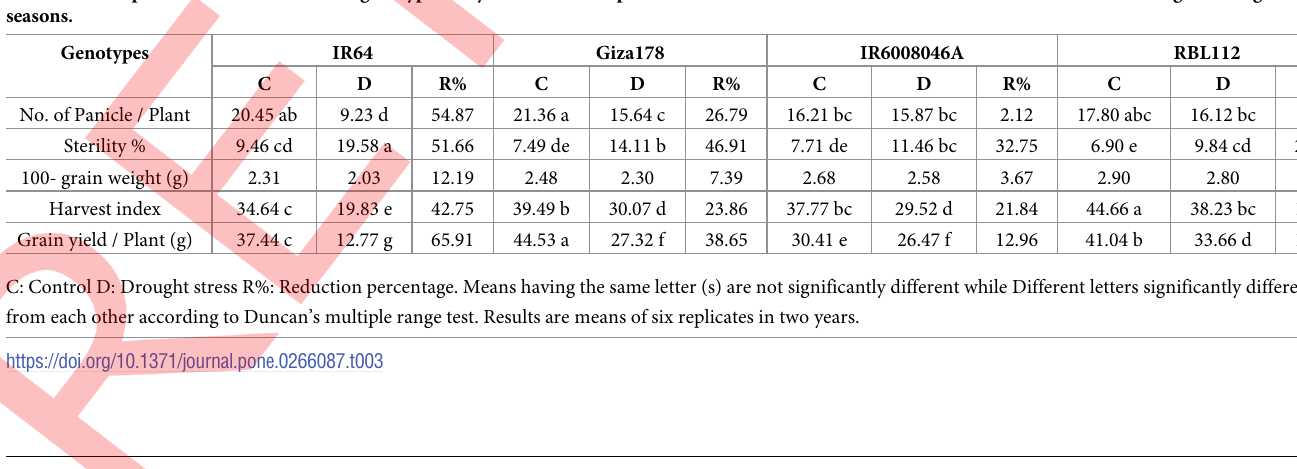
of water used during the growing season [29,30]. It was found that drought stress remarkably reduced the plant height, tiller plant -1 , flag leaf area, panicle length, and total chlorophyll con- tent in all rice genotypes (Table 2). Interestingly, for those traits the candidate line RBL112 exhibited the least reduction percentage as well as the most desired performance as compared to other genotypes. Drought-stress negatively affected the root length and root volume, how- ever, the studied genotypes displayed significant differences in these two traits under normal and drought-stress conditions (Table 2). The candidate line RBL-112 showed the maximum root length and volume under drought-stress, and was more similar to those of IR60080-46 which indicated that the deep-rooted-RBL-112 line and IR60080-46A were well adapted to water-stress than other ones. The significant reduction in the grain yield and its components traits in the four tested genotypes were noticed under drought-stress conditions compared with control (Table 3). However, under the drought-stress, the candidate line RBL-112 consistently showed improved performance, even when compared to its drought-resistant parent, IR60080-46A (Table 3). Drought-stress significantly increased the sterility percentage in all the studied genotypes and was most pronounced in the drought-sensitive variety IR64. The candidate line RBL-112 showed a comparable decrease in sterility to IR6008046A but this was significantly less than the 46.91% increase in sterility observed in the Giza-178 recurrent parent (Table 3). The drought-stress reduced the 100-grain weight in all genotypes since the reduction was minimal in the candidate line RBL-112 with reduction of 3.42% (Table 3). The drought-stress caused a